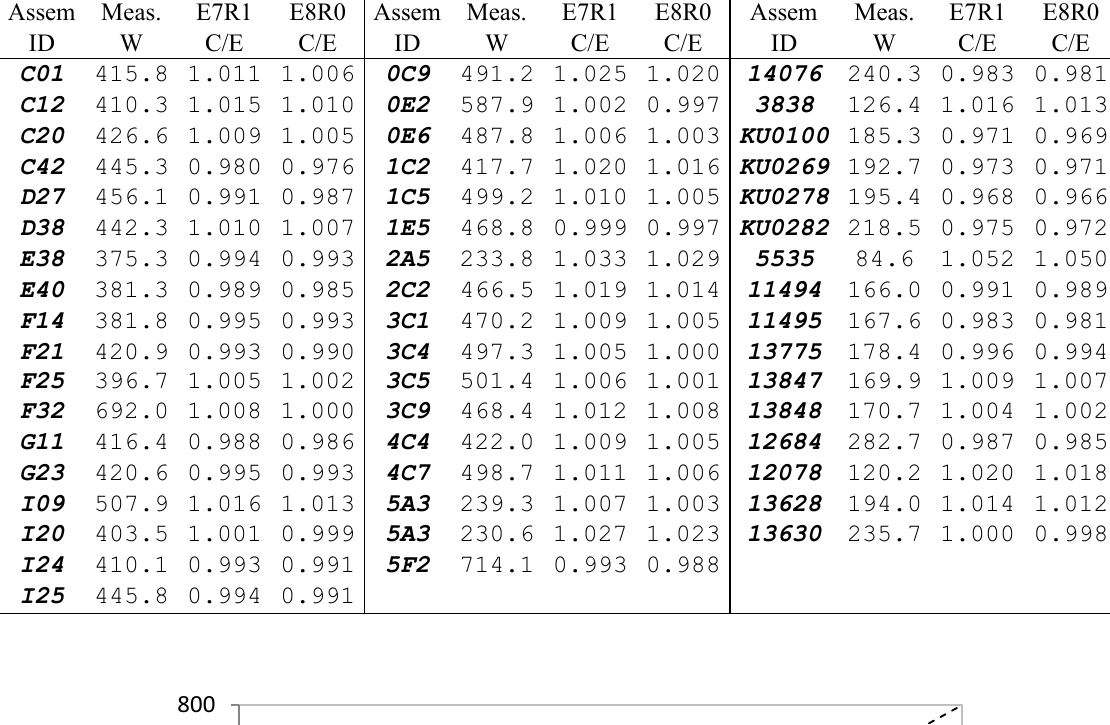
Table I. C/E comparison between CMS5/SNF and CLAB measurements.